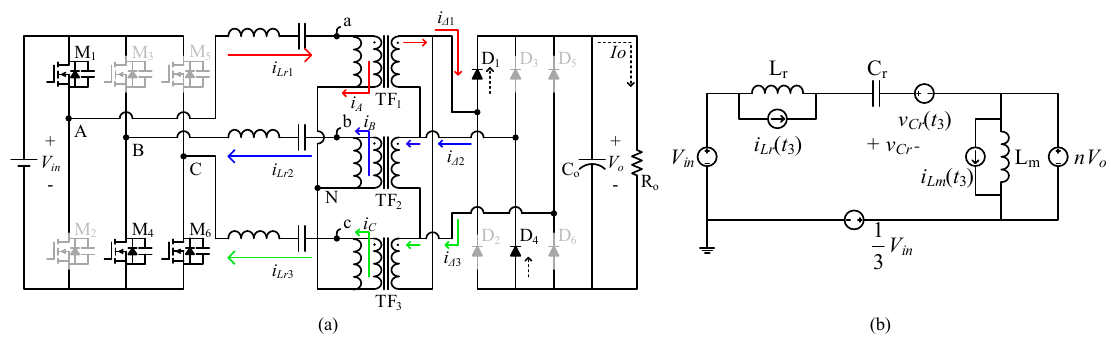
Figure 7. ( a ) Circuit station at Stage 4 ( b ) Equivalent circuit at Stage 4.